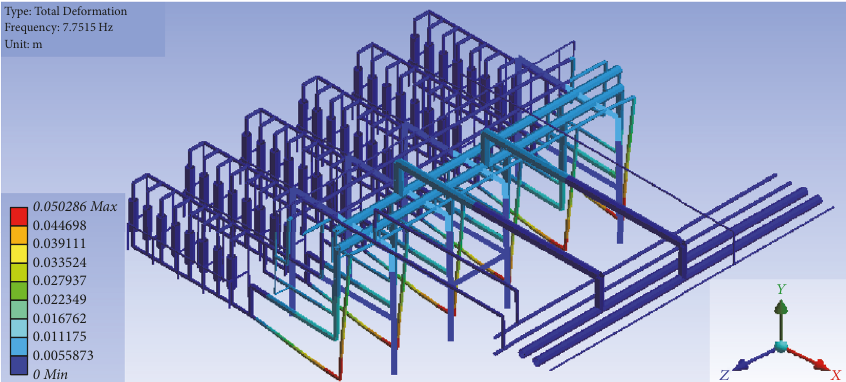
Figure 9: Vibration mode of the 4th modal order.